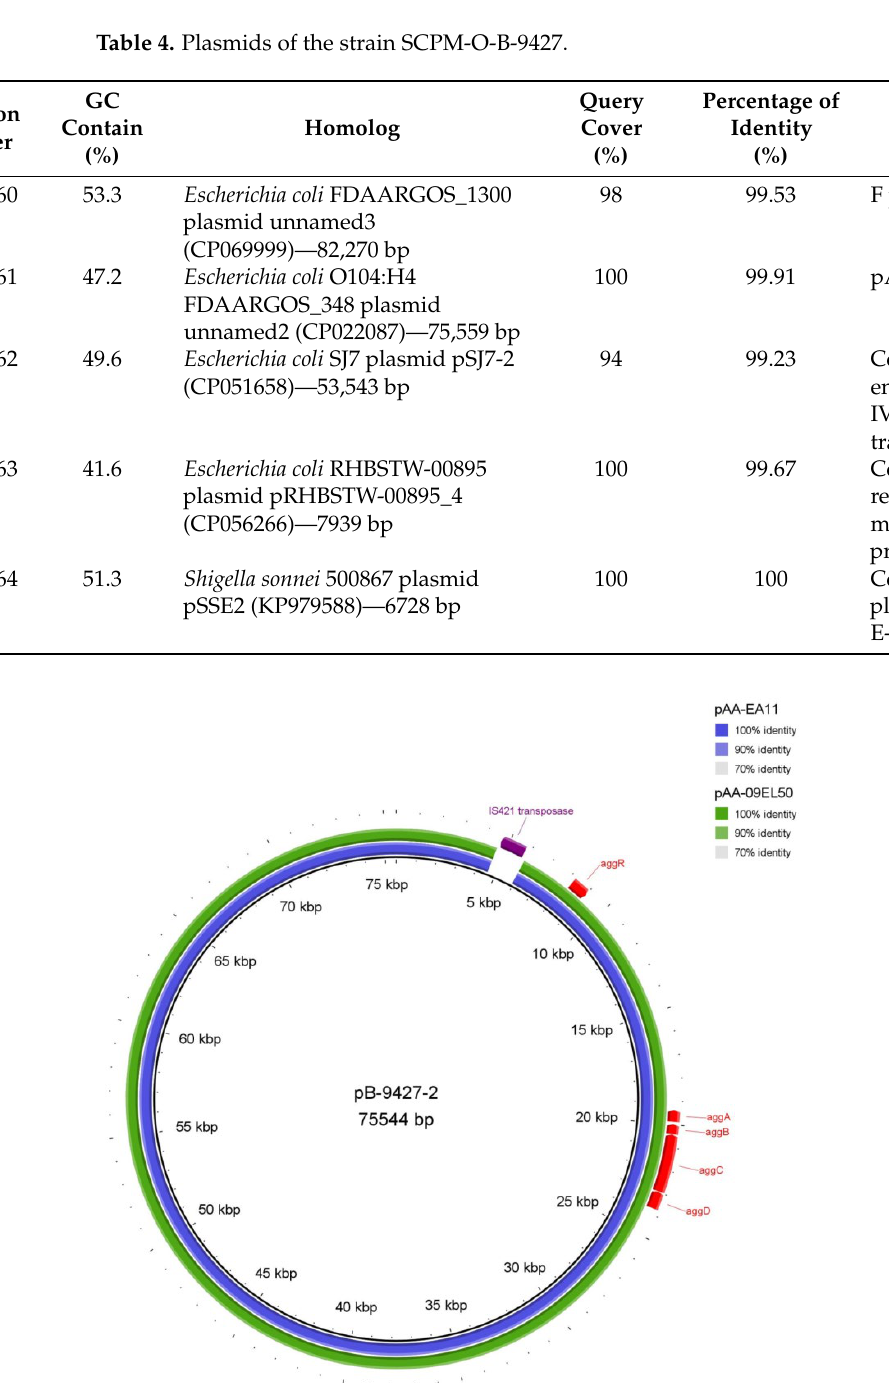
Figure 4. BRIG diagram of pAA plasmids comparison. From the center to outside: pB-9427-2 (black ring), pAA-09EL50 (blue ring), and pAA-EA11 (green ring). The cluster genes aggDCBA coding aggregative adhesion fimbriae (AAF) and transcriptional activator aggR are indicated (colored red). An additional insertion caused by IS4-like element IS421 family transposase in pB-9427-2 is shown (colored violet).